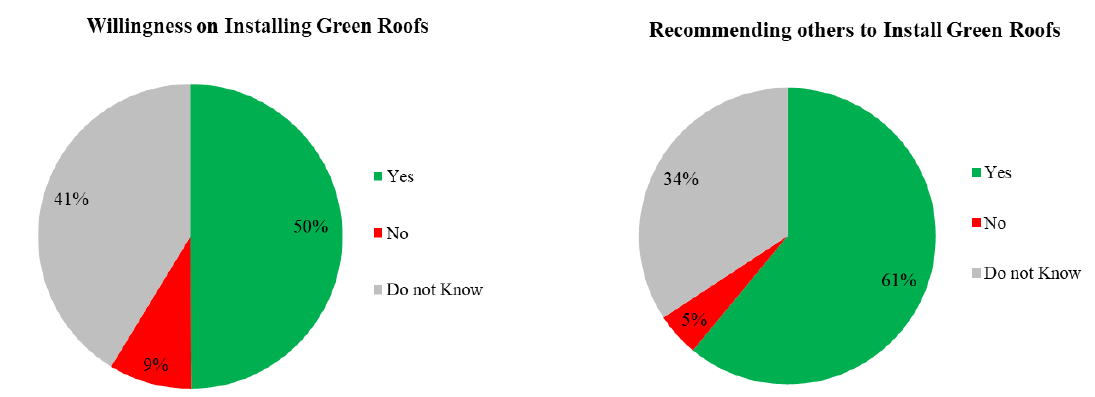
Figure 9. Response to supplementary questions.